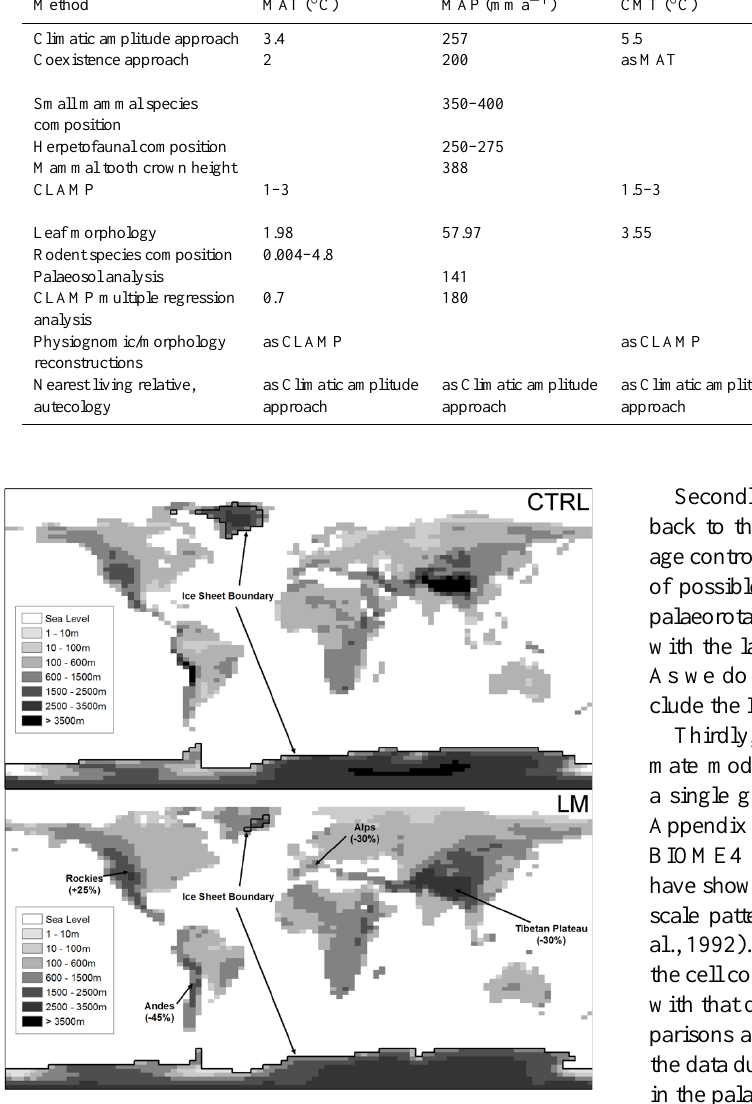
Fig. 2. Model orographic and ice sheet configurations for the prein- dustrial (CTRL) and the late Miocene (LM). The LM panel shows the percentage differences in high topography between CTRL and